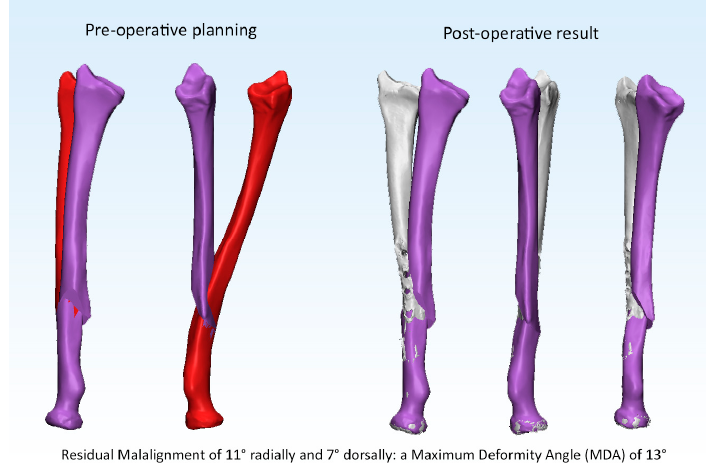
Figure 3. Example of an anatomic correction of the radius.